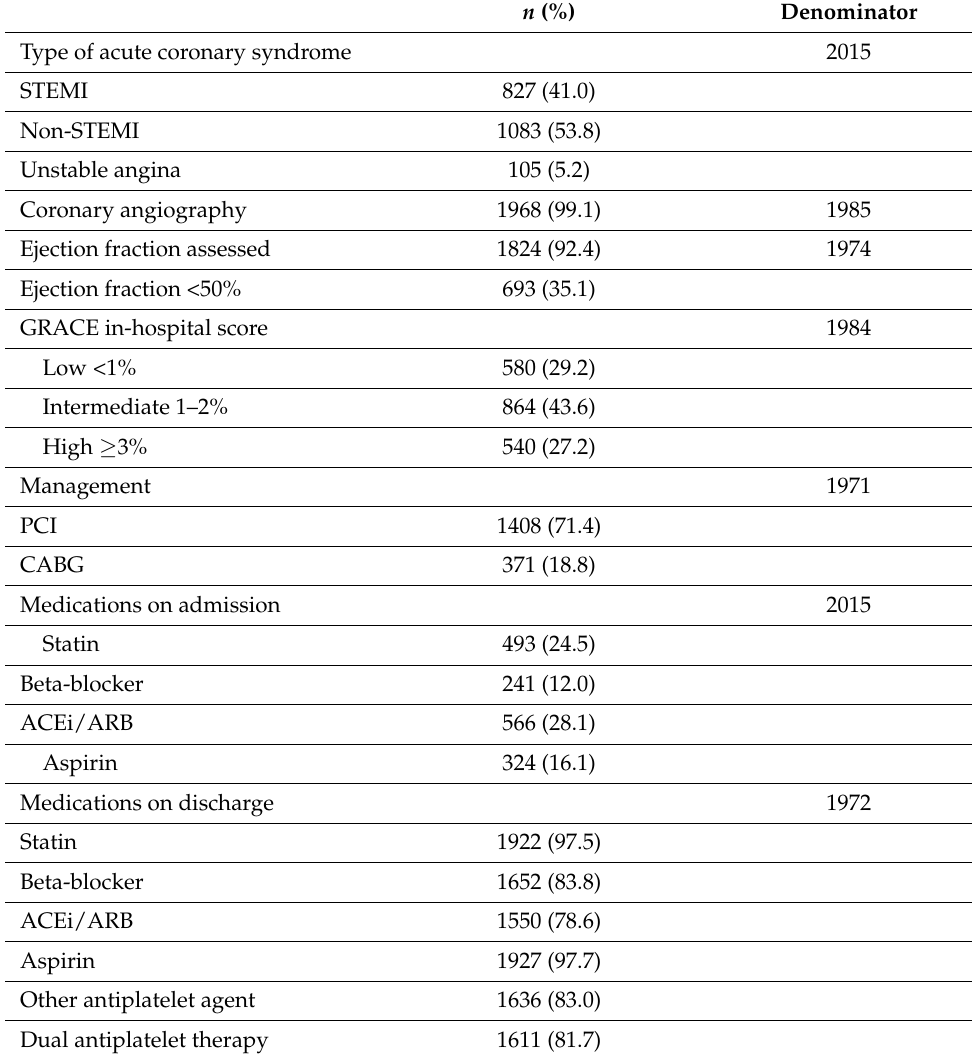
Table 2. Baseline clinical characteristics of the MENZACS